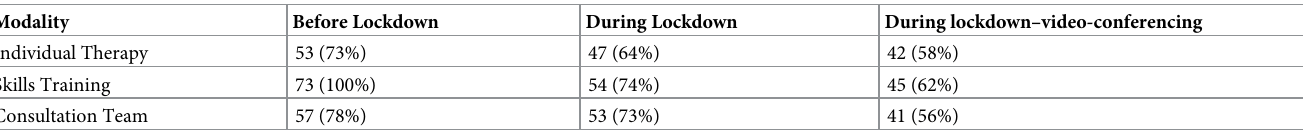
Table 1. Modalities provided before and during lockdown by respondents’ DBT teams.